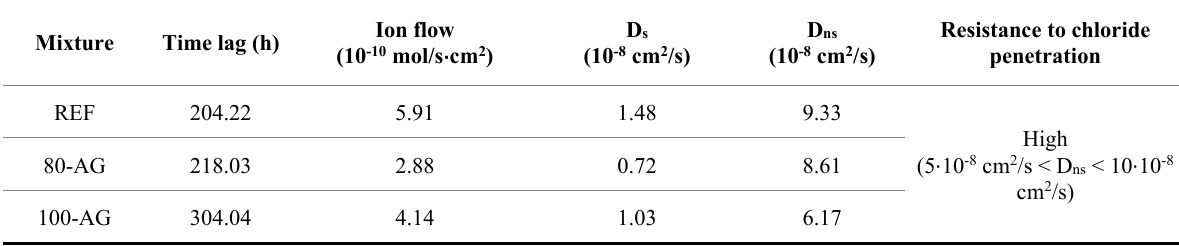
Table 5. Classification of concretes with different mortar contents as to resistance to chloride penetration, according to the limits established by Nilsson et al.